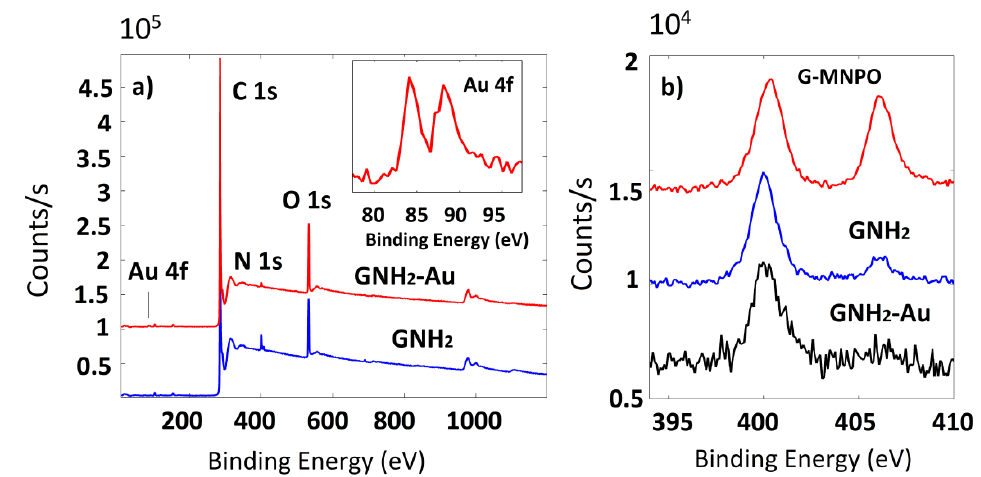
Figure 4. ( a ): XPS wide scan of G-NH 2 and G-NH 2 /Au samples and line shapes of Au 4f (inset). ( b ): N 1s photoelectron deconvoluted line shapes of G-MNPO, G-NH 2 , and G-NH 2 /Au.